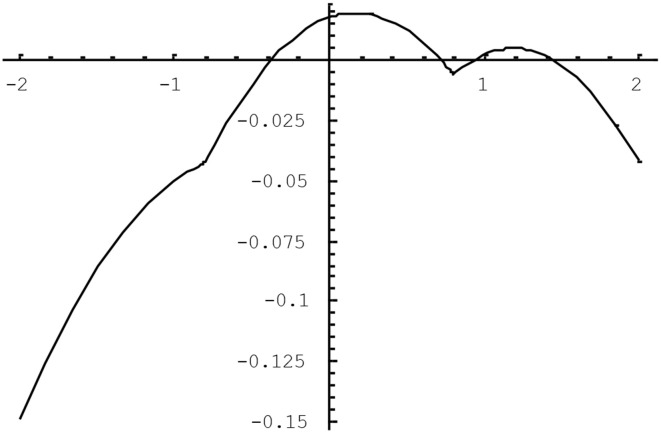
ρ*ab − ρab as a function of threshold hb for ha = 0.8 and ρab = 0.5.